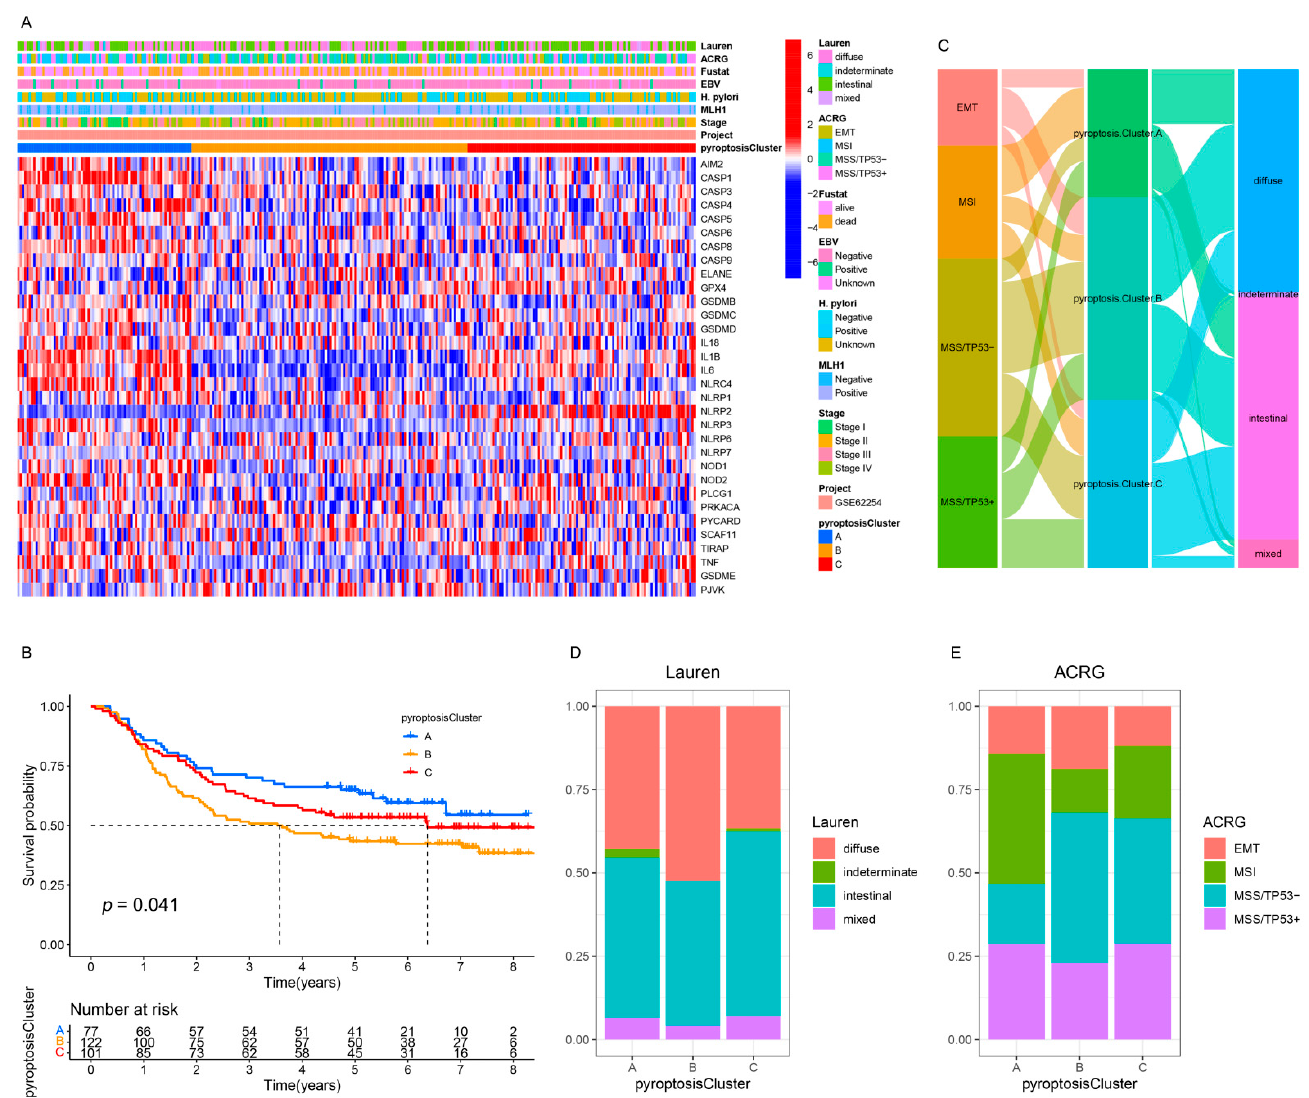
Figure 4. Integrated analysis of three pyroptosis patterns in the GSE62254/ACRG cohort. ( A ) The heatmap of the expression of the PRs and clinicopathologic traits in distinct pyroptosis patterns. ( B ) Kaplan–Meier analysis of the OS for GC patients with distinct pyroptosis patterns (Log-rank test: p = 0.041). ( C ) Alluvial diagram of pyroptosis patterns in groups with different molecular subtypes. ( D , E ) The proportion of Lauren subtypes ( D ) and ACRG subtypes ( E ) in the three pyroptosis patterns.